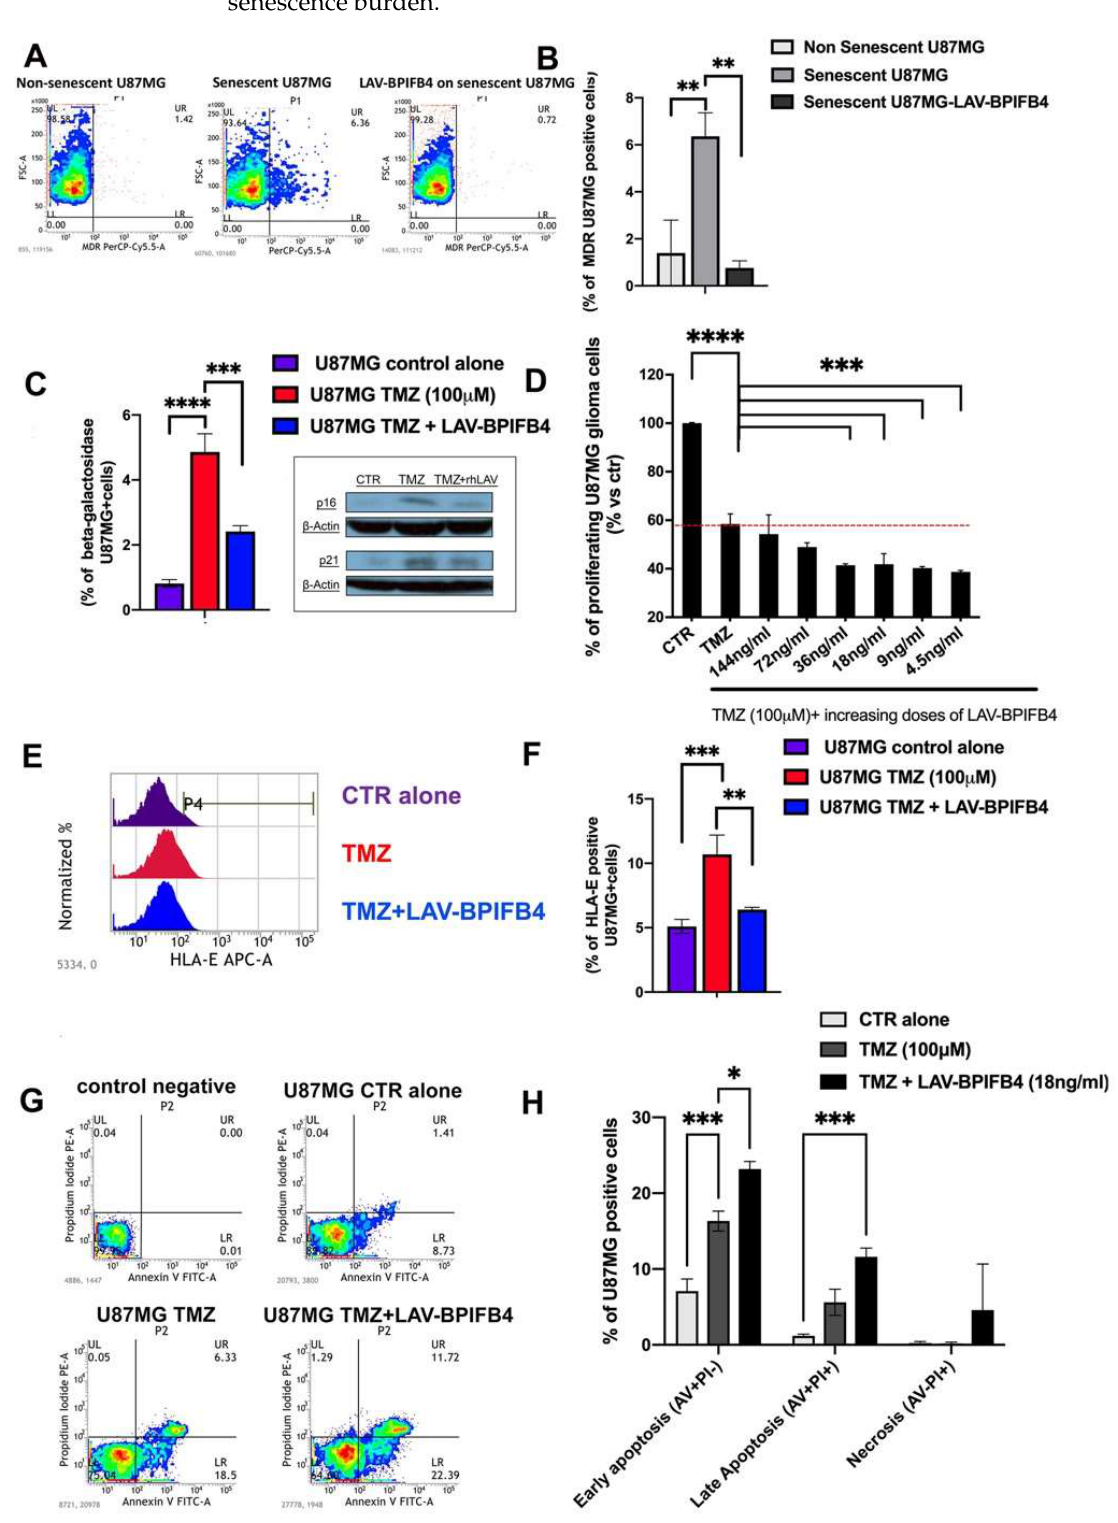
Figure 3. Drug sensibilization in senescent U87-MG glioblastoma cell line. ( A ) Representative FACS dot plots showing the percentages of multidrug resistance protein (MDR)-positive U87-MG cells in different conditions as indicated. After inducing senescence with etoposide, the percentage of MDR- positive cells rose to 6.36%, and the 48 h treatment with rhLAV-BPIFB4 reduced this value to 0.72%. ( B ) Bar graph reporting the mean percentage values ± SD of MDR+ viable cells from 3 independent experiments. ( C ) Cytofluorometric analysis of Spider-β galactosidase in the U87-MG glioma cell line after 24 h treatment with TMZ (100 μM) and 5 days resting in the absence or presence with rhLAV- BPIFB4 for the last 48 h. The right panel reports the Western blot analysis of p16 and p21 senescence- related proteins in the same experimental condition. β-Actin was used as a control for quantitation of the sample protein. ( D ) BrdU proliferation assay on the U87-MG cell line after treatment with temozolomide (96 h, 100 μM). The LAV-BPIFB4 co-treatment induced a higher sensibilization to the drug in a dose–response manner. ( E ) Cytofluorimetric analysis of the HLA-E expression. The panel on left side shows a representative, of three independent experiments, histogram profile of HLA-E staining on U87-MG cells’ surface in the control and TMZ-treated cells with or without rhLAV-